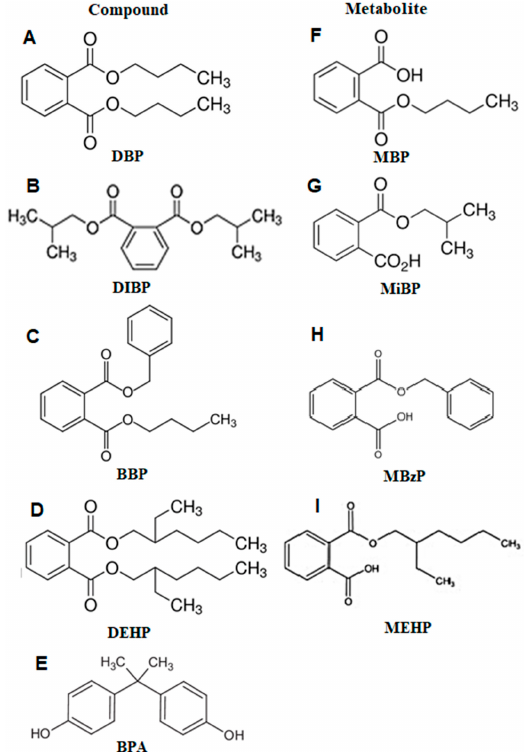
Figure 1. Chemical structures of phthalates ( A , B , C , D ), their metabolites ( F , G , H , I ) and BPA ( E ). DBP, Dibutyl phthalate. DIBP, Diisobutyl phthalate. BBP, Benzyl butyl phthalate. DEHP, di(2-ethylhexyl) phthalate. BPA, Bisphenol A. MBP, Mono-n-butyl phthalate. MiBP, Mono-isobutyl phthalate. MBzP, Mono-benzyl phthalate. MEHP, Mono(2-ethyl hexyl) phthalate.